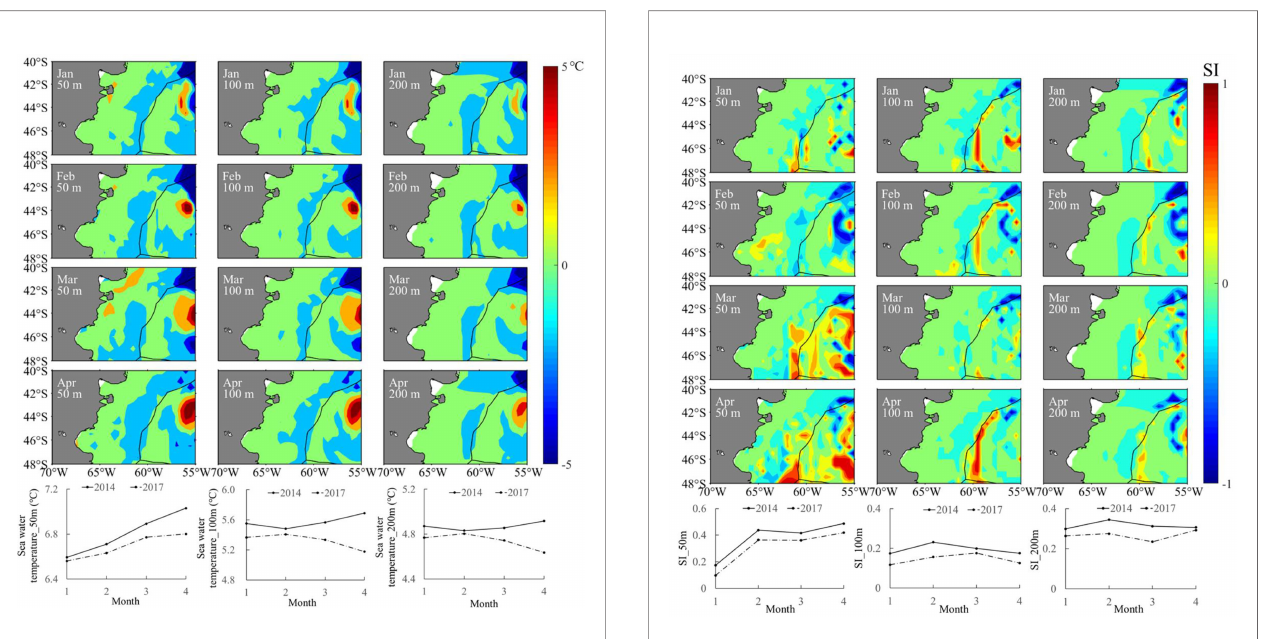
FIGURE 8 | Spatial and temporal difference in sea water temperature (the upper panel) and average sea water temperature (lower panel) from January to April between 2014 and 2017 at depths of 50, 100, and 200 m in the Southwest Atlantic Ocean.